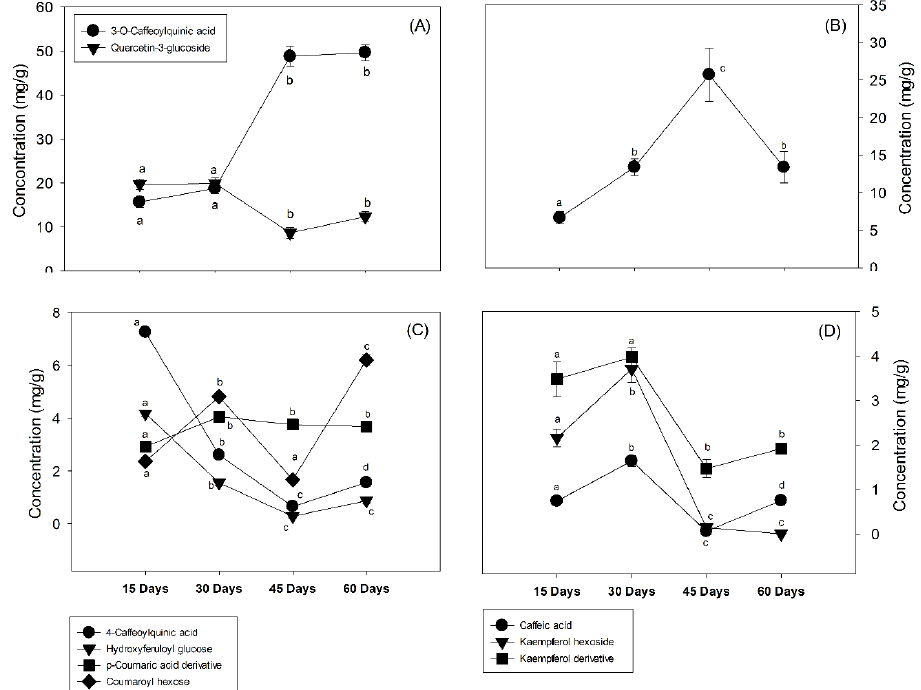
Figure 2. Changes in the polyphenolic compounds of apricot leaves during maturation. ( A ) 3- O -Caffeoylquinic acid, quercetin-3-glucoside; ( B ) 5- O -Caffeoylquinic acid; ( C ) 4- O -Caffeoylquinic acid, hydroxyferuloyl glucose, p-coumaric acid derivative; and ( D ) caffeic acid, kaempferol hexoside, and laempferol derivative. Significant levels are mentioned in the